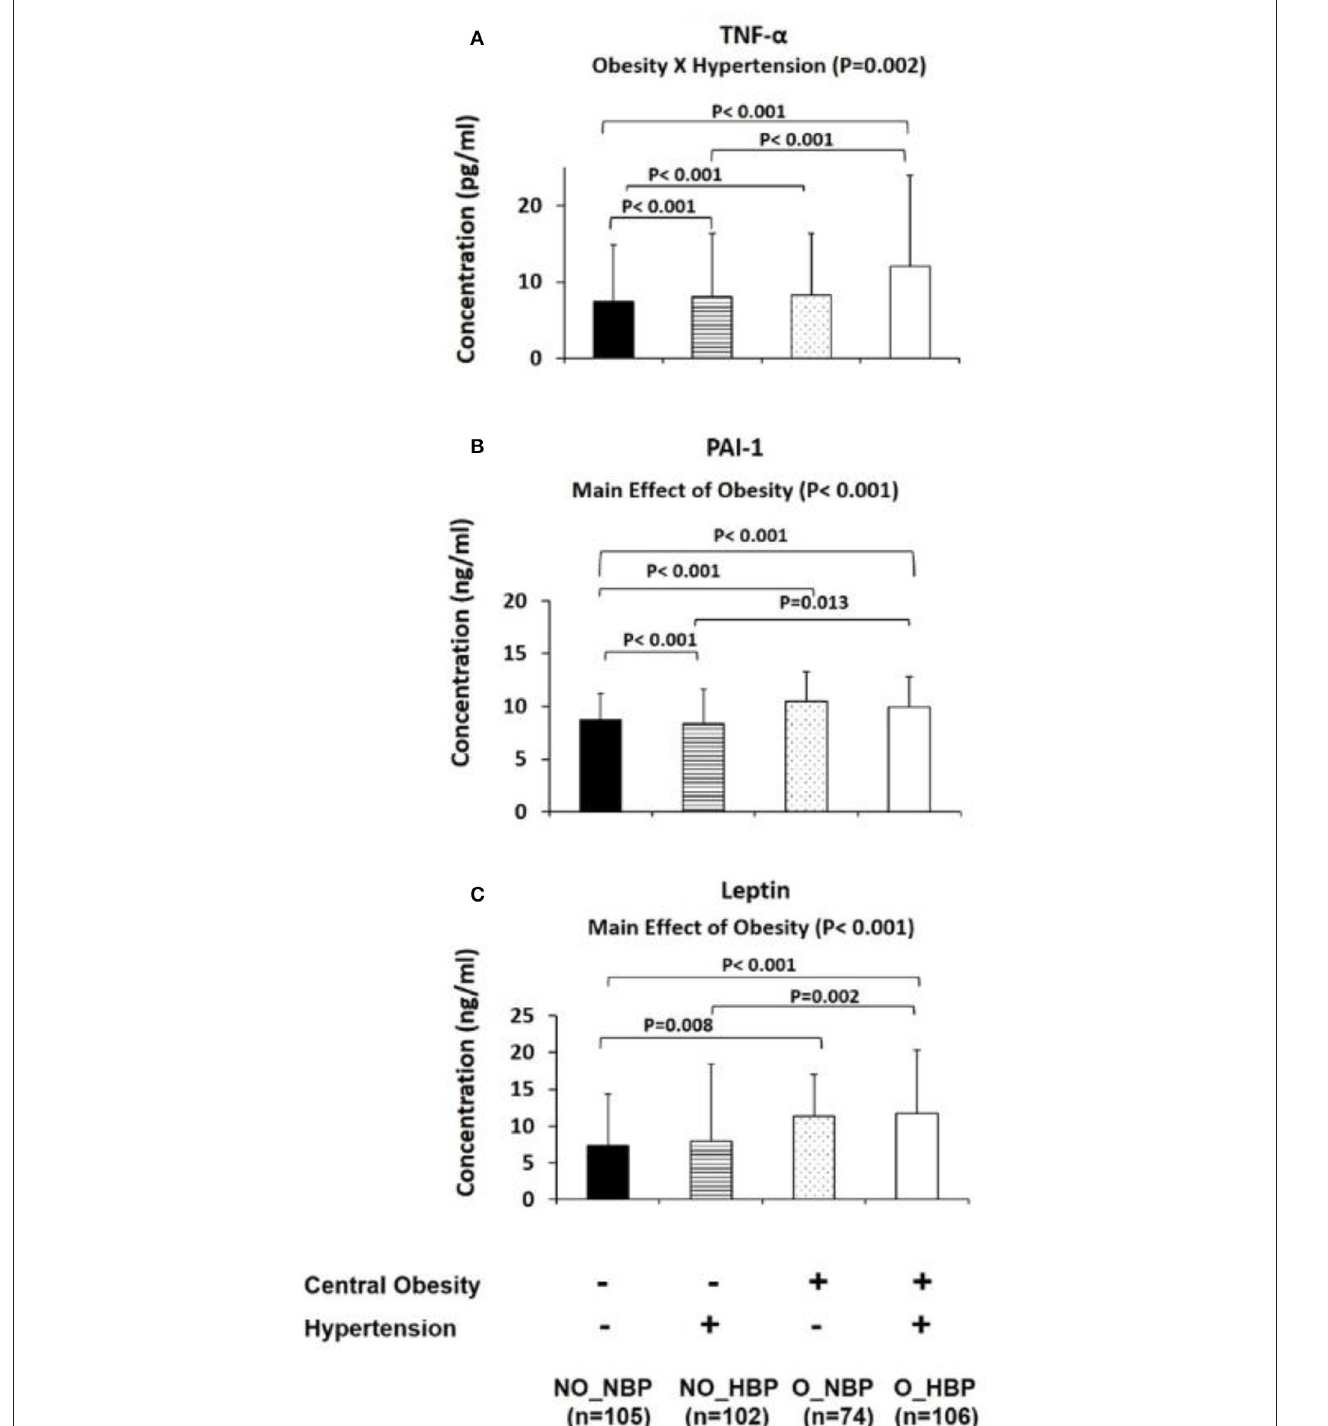
FIGURE 3 | Bar graphs represent circulatory abundance of pro-inflammatory adipokines, including PAI-1 (A) , TNF- α (B) , and leptin (C) in Hong Kong Chinese women categorized into four groups, including (1) Non-central obese subjects with normal blood pressure (NO_NBP; n = 105), (2) Non-central obese subjects with hypertension (NO_HBP; n = 102), (3) Central obese subjects with normal blood pressure (O_NBP; n = 74), and (4) Central obese subjects with hypertension (O_HBP; n = 106). Subjects with hypertension were defined with systolic blood pressure ≥ 140 mmHg and diastolic blood pressure ≥ 90 mmHg, and subjects with central obesity were defined as having a waist circumference ≥ 80cm. The data are expressed as the mean ± standard deviation.